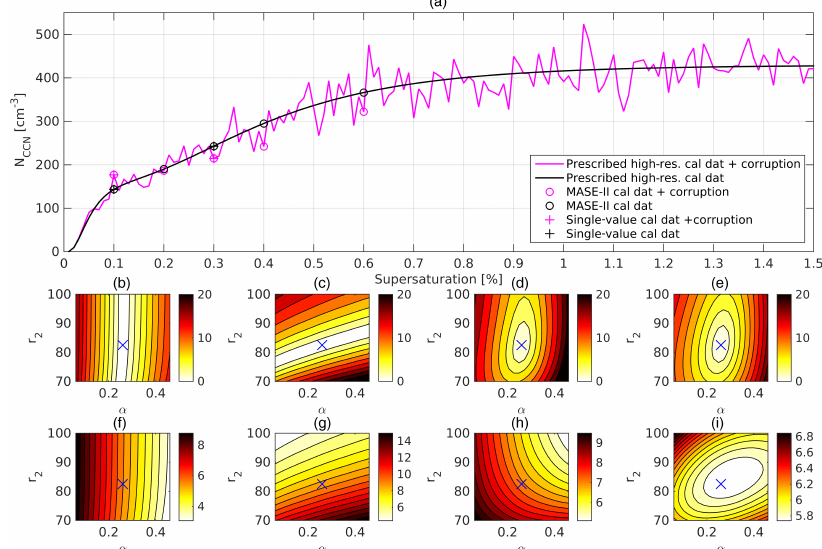
Figure 13. (a) Multiple definitions of calibration data (cal dat). Uncorrupted calibration data are shown in black for high-resolution synthetic CCN spectrum (solid line), supersaturation bands corresponding to CCNC measurements from the second Marine Stratus/Stratocumulus Experiment (MASE-II) campaign (circles), and two single-value definitions at 0.1 and 0.3% (crosses). Calibration data with randomly generated error corruption assuming a standard deviation of 10% of the uncorrupted values are shown in magenta. (b–e) Left to right: OF response surfaces corresponding to the uncorrupted single values 0.3 and 0.1%, MASE-II supersaturation bands, and synthetic CCN spectrum definitions of calibration data. (f–i) Response surfaces as in (b–e) but with the corruption of calibration data and residual weightings in the OF. Surfaces left to right are increasing in information